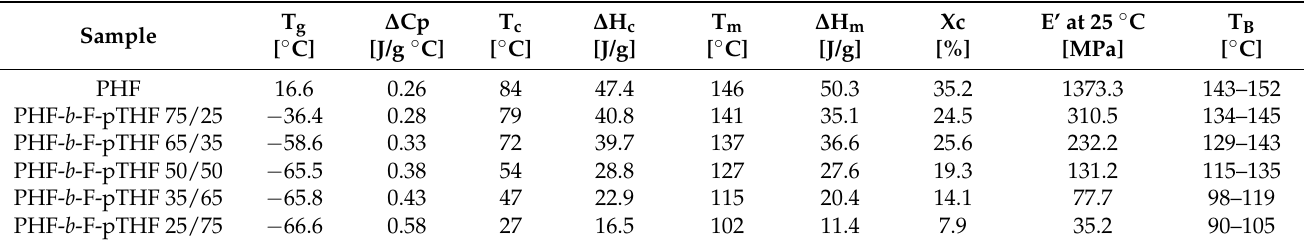
Table 2. Thermal properties determined from cooling and 2nd heating thermograms, storage